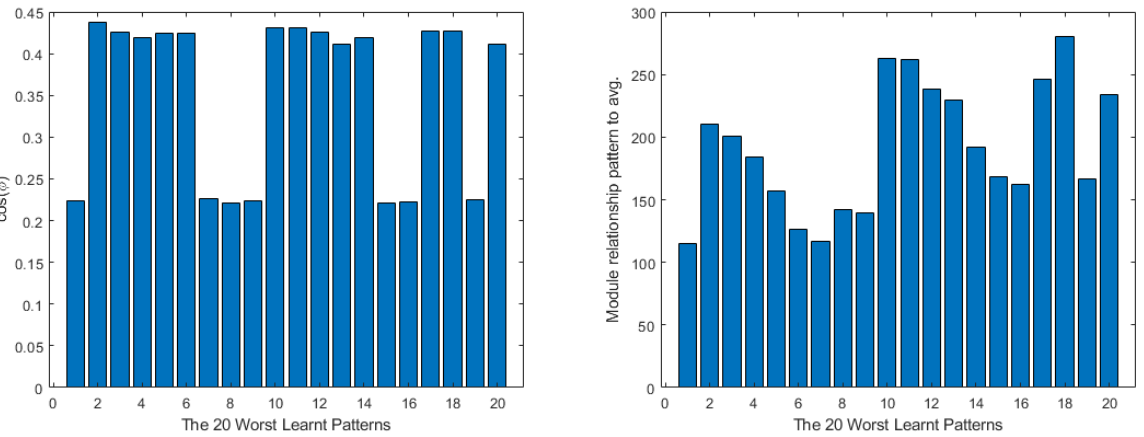
𝜕𝐿𝑜𝑠𝑠 | relationship to the average 𝜕𝑊 𝑛 | relationship to the average 𝜕𝑊 𝑛